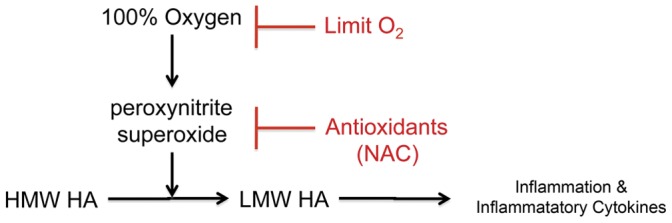
Overall model of the role of oxidative and nitrative stresses and LMW HA in asphyxia and hyperoxia-stimulated inflammation.Exposure to 100% oxygen in asphyxiated newborn pigs results in the production of superoxide and peroxynitrite that cause the fragmentation of HMW to LMW HA. LMW HA, in turn stimulates inflammatory cytokine expression in macrophages and promotes inflammation. Strategies to prevent the formation of LMW HA, such as limiting oxygen exposure or treatment with antioxidants (the current work) will result in decreased inflammation. This model predicts that direct blockade of LMW HA should also achieve the same result.